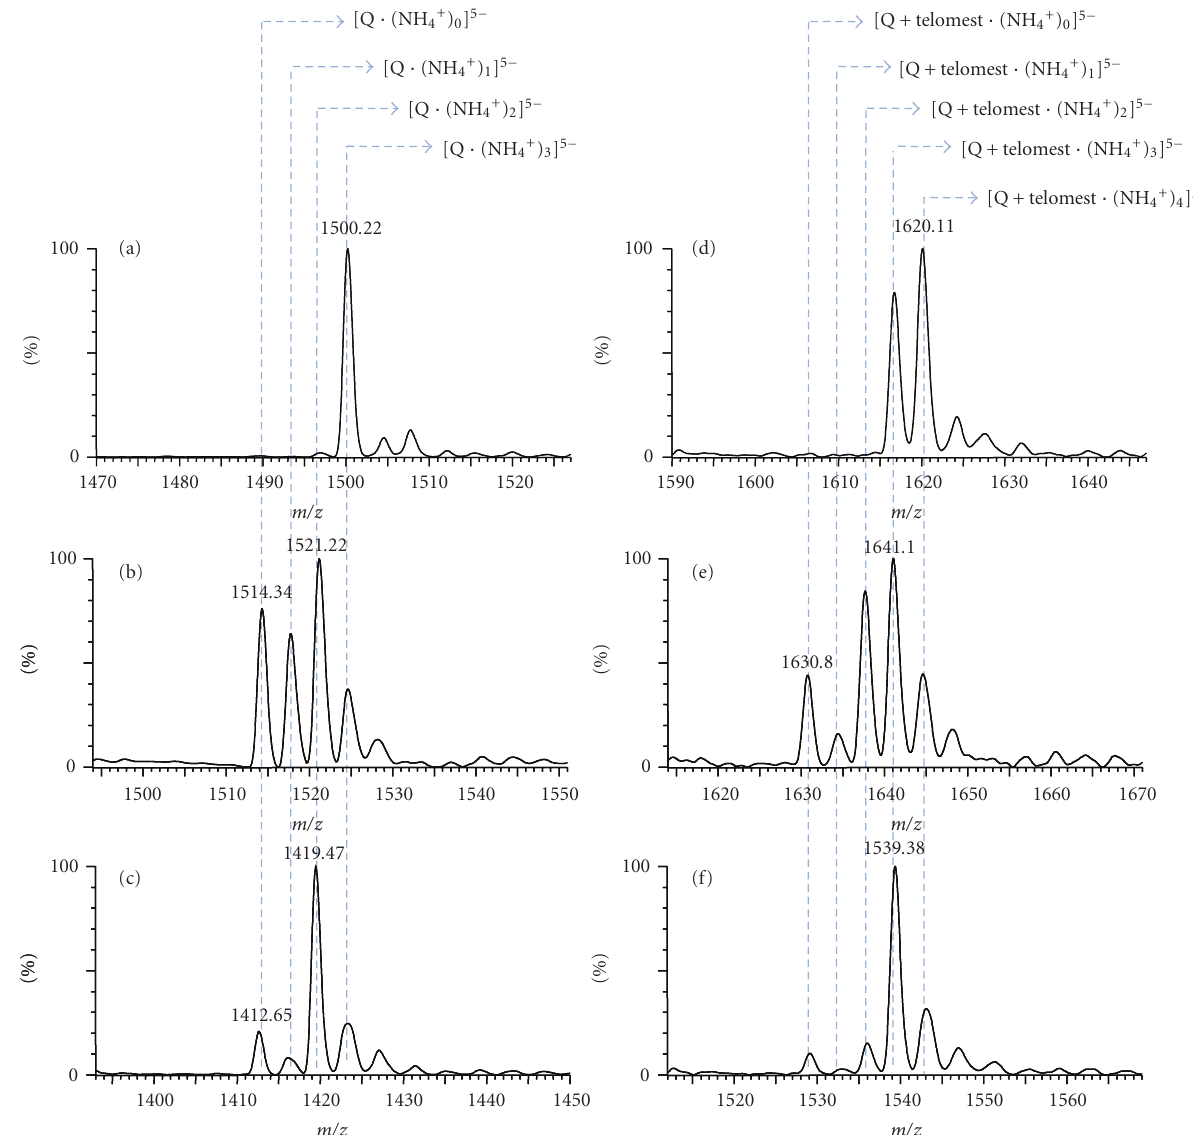
Figure 2: Negative ion mode electrospray mass spectra of mixtures of 10 μ M telomestatin and 5 μ M of G-quadruplexes. Zooms on the peaks of free G-quadruplex (a) [TG 4 T] 4 , (b) telomeric sequence (T 2 AG 3 ) and on the complexes between (d) one telomestatin and [TG 4 T] 4 , (e) one telomestatin and (T 2 AG 3 ) GAG 3 TG 4 AG 3 TG 4 A 2 G. The spectra were recorded from and 80/20 aqueous ammonium acetate (150mM)/methanol solution, using soft source conditions to preserve the specifically bound ammonium